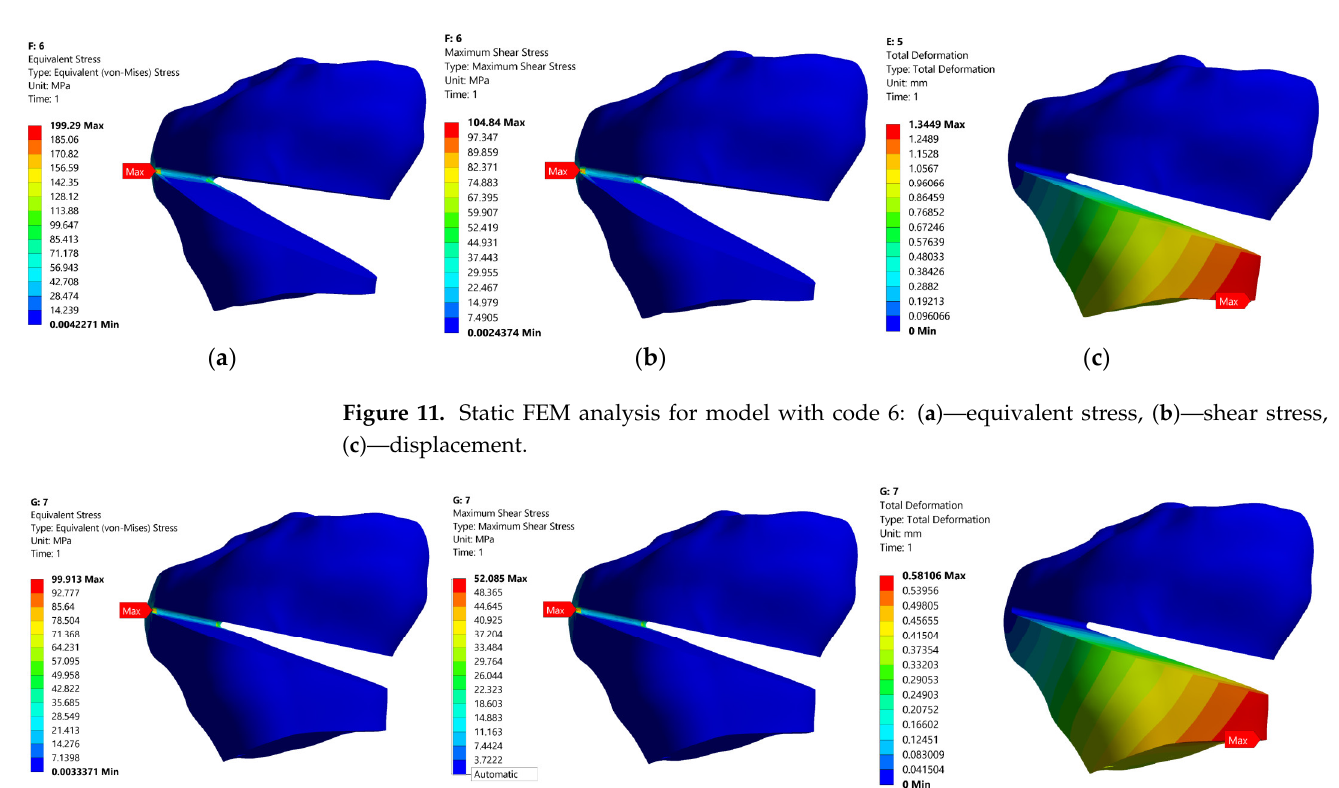
Table 4. Regression equations for: equivalent stress, shear stress, displacement.